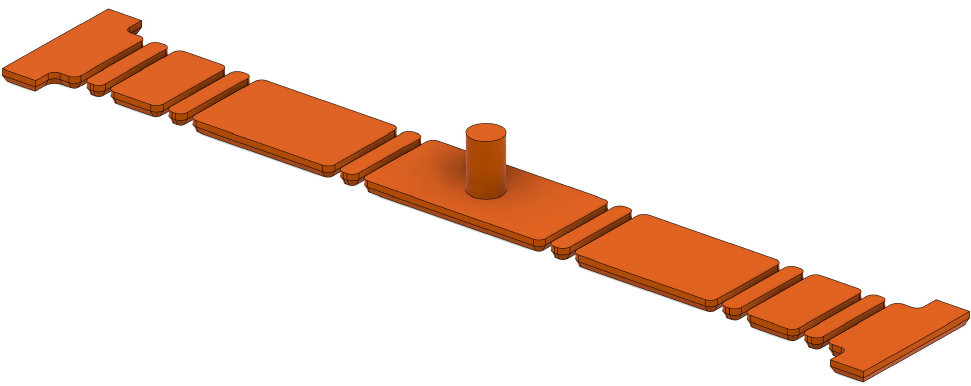
Figure 2. Design of the 3D-printed mechanism.